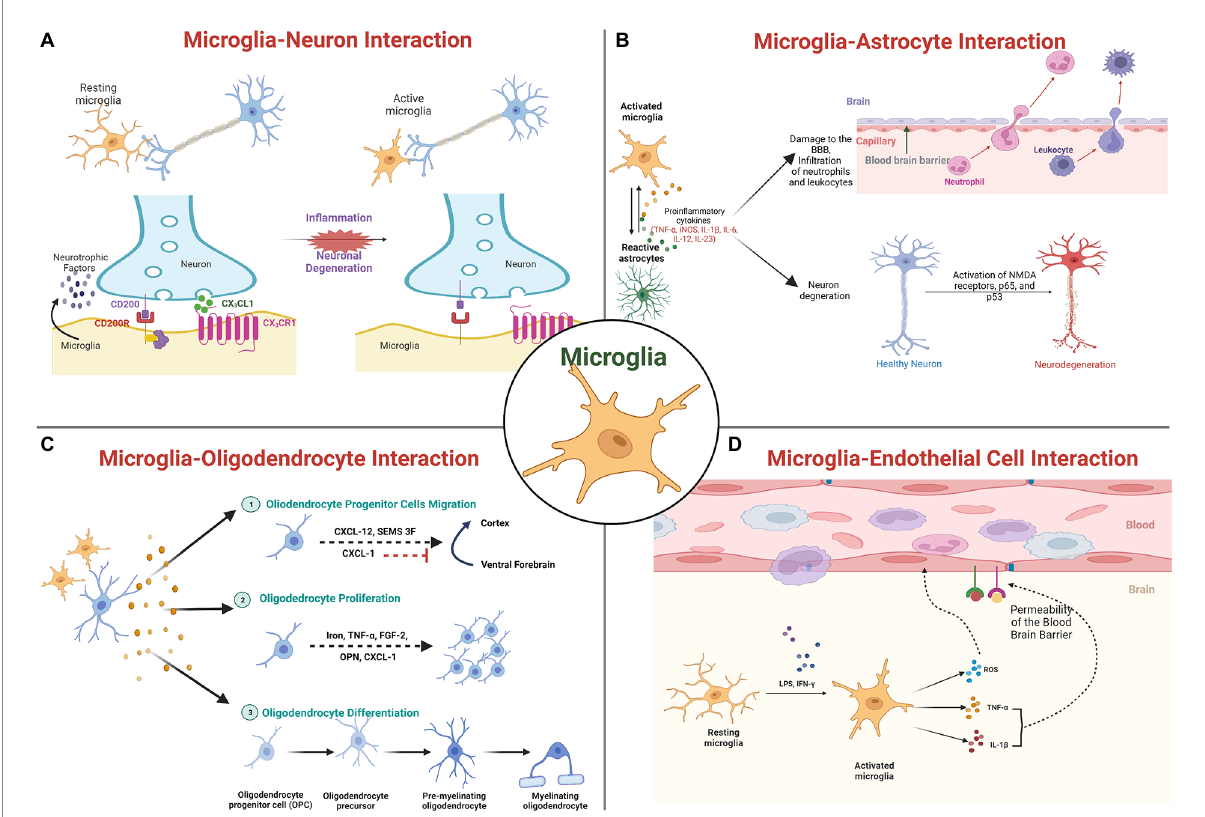
FIGURE 1 Molecular interaction of microglia with brain cells: (A) Microglia-Neuronal interactions; (B) Microglia-Astrocyte interaction; (C) Microglia- Oligodendrocyte interactions; and (D) Microglia-Cerebrovascular endothelial cells